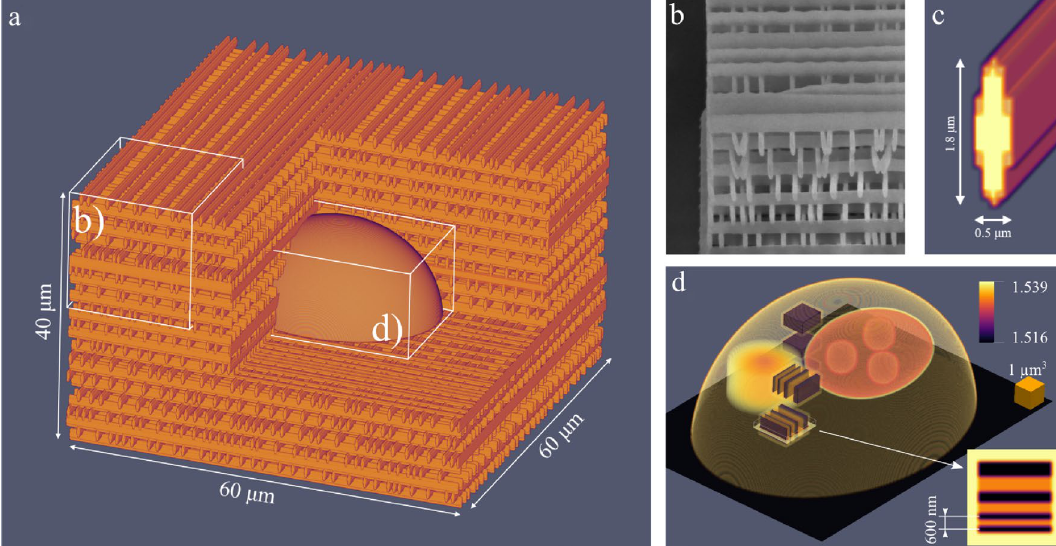
Figure 1. ( a ) Half-section view of the scattering microphantom design. ( b ) SEM image of a scattering layer made out of quasi-randomly distributed rods. ( c ) Individual rod that comprises a scattering layer. ( d ) Visualization of the 3D RI distribution of the imaging target—cell phantom. Subcellular features, such as resolution targets (shown in the inset) and cell nucleoli, are enclosed in truncated ellipsoid with the external dimensions of 30 µ m × 25 µ m × 12 µ m, which is then embedded in the center of the 60 µ m × 60 µ m × 40 µ m scattering